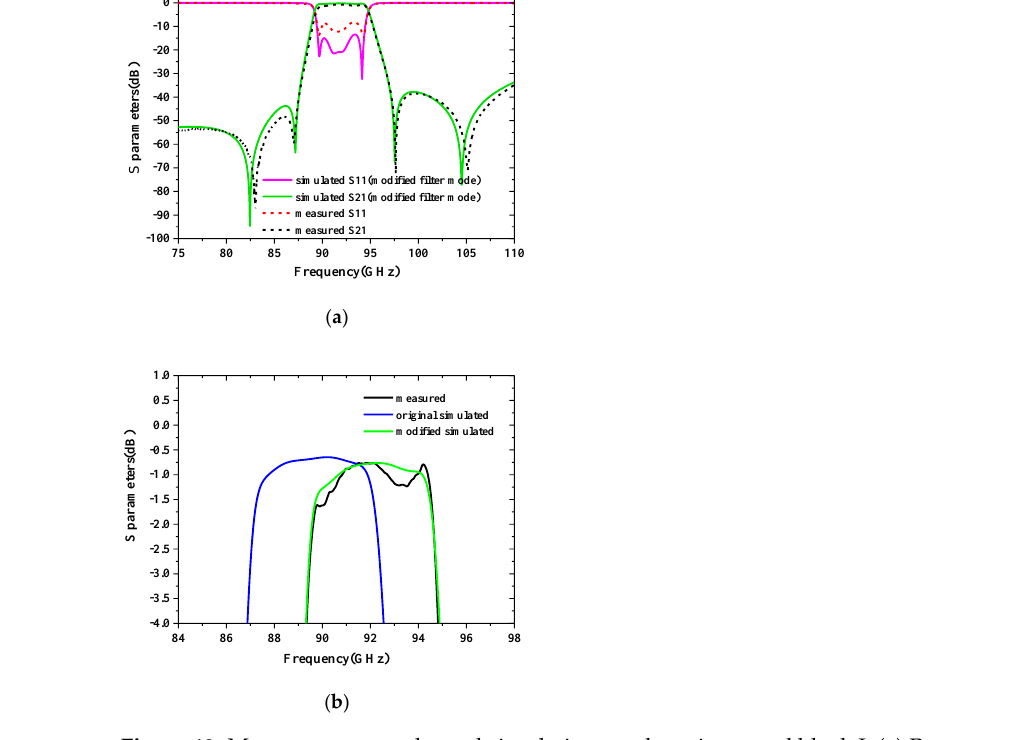
Figure 13. Measurement results and simulation results using metal block Ⅰ . ( a ) Responses over the whole W -band. ( b ) Expanded view of S 21 over the passband. whole W -band. ( b ) Expanded view of S 21 over the passband. 4.4. Stress and Deformation Analysis of the Fabricated SU8 Chips during Measurement